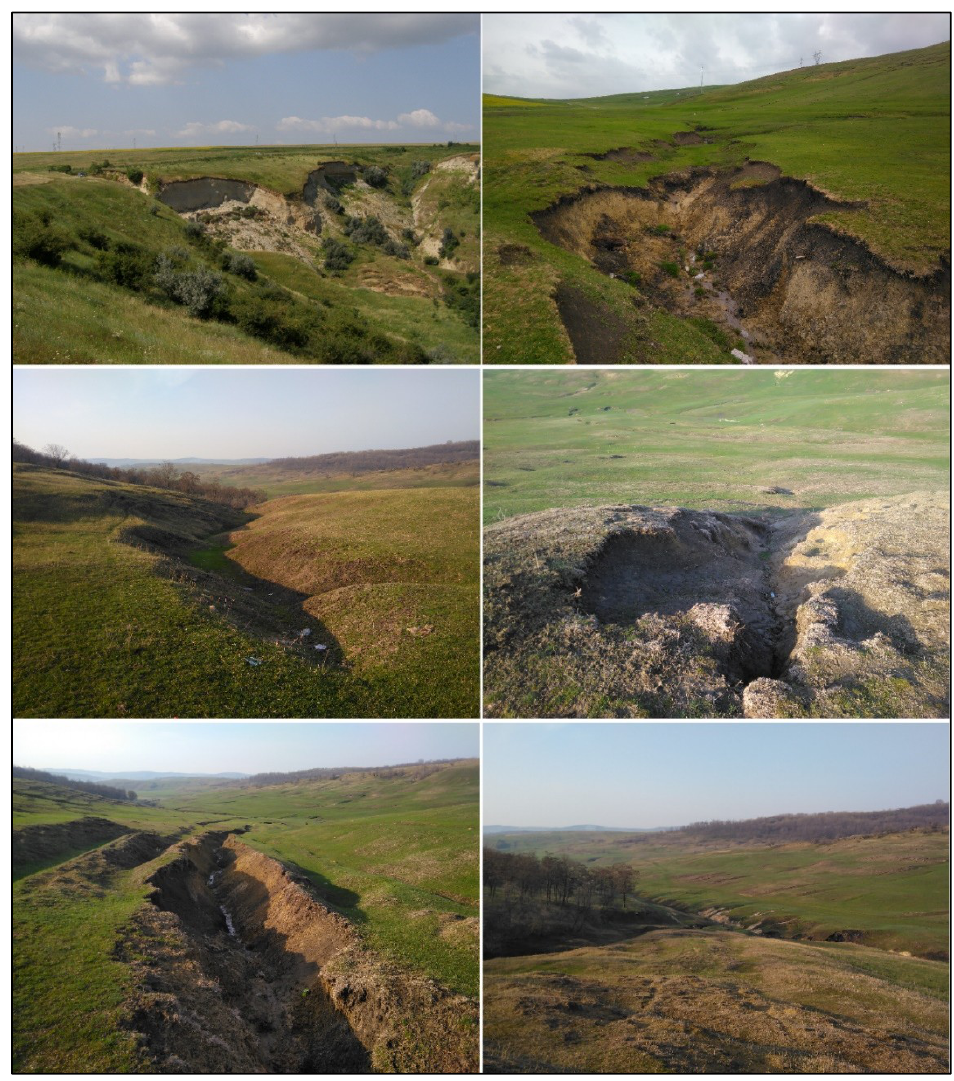
Figure 3. Examples of gully erosion from the study area.